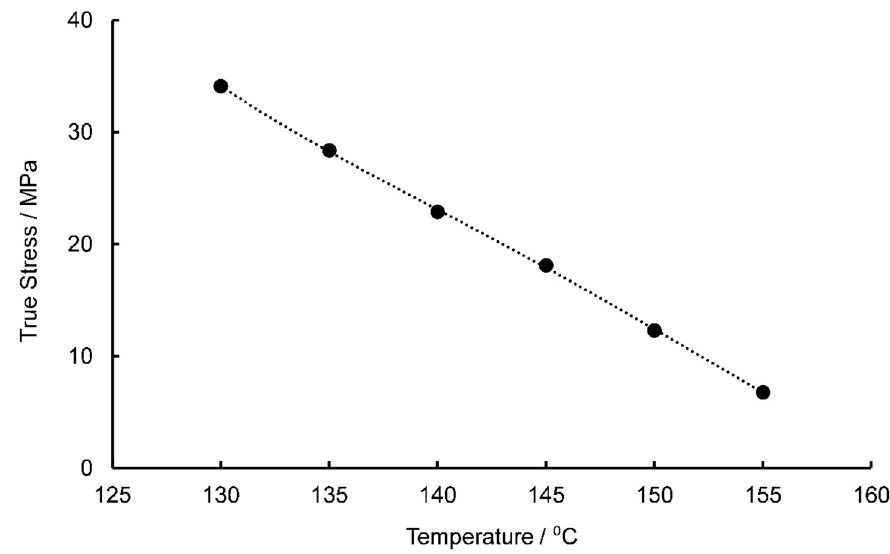
Figure 7. Eyring plots for EB deformation of PEEK between temperatures of 130–150 °C, at a nominal strain rate range of 1–16 s − 1 .